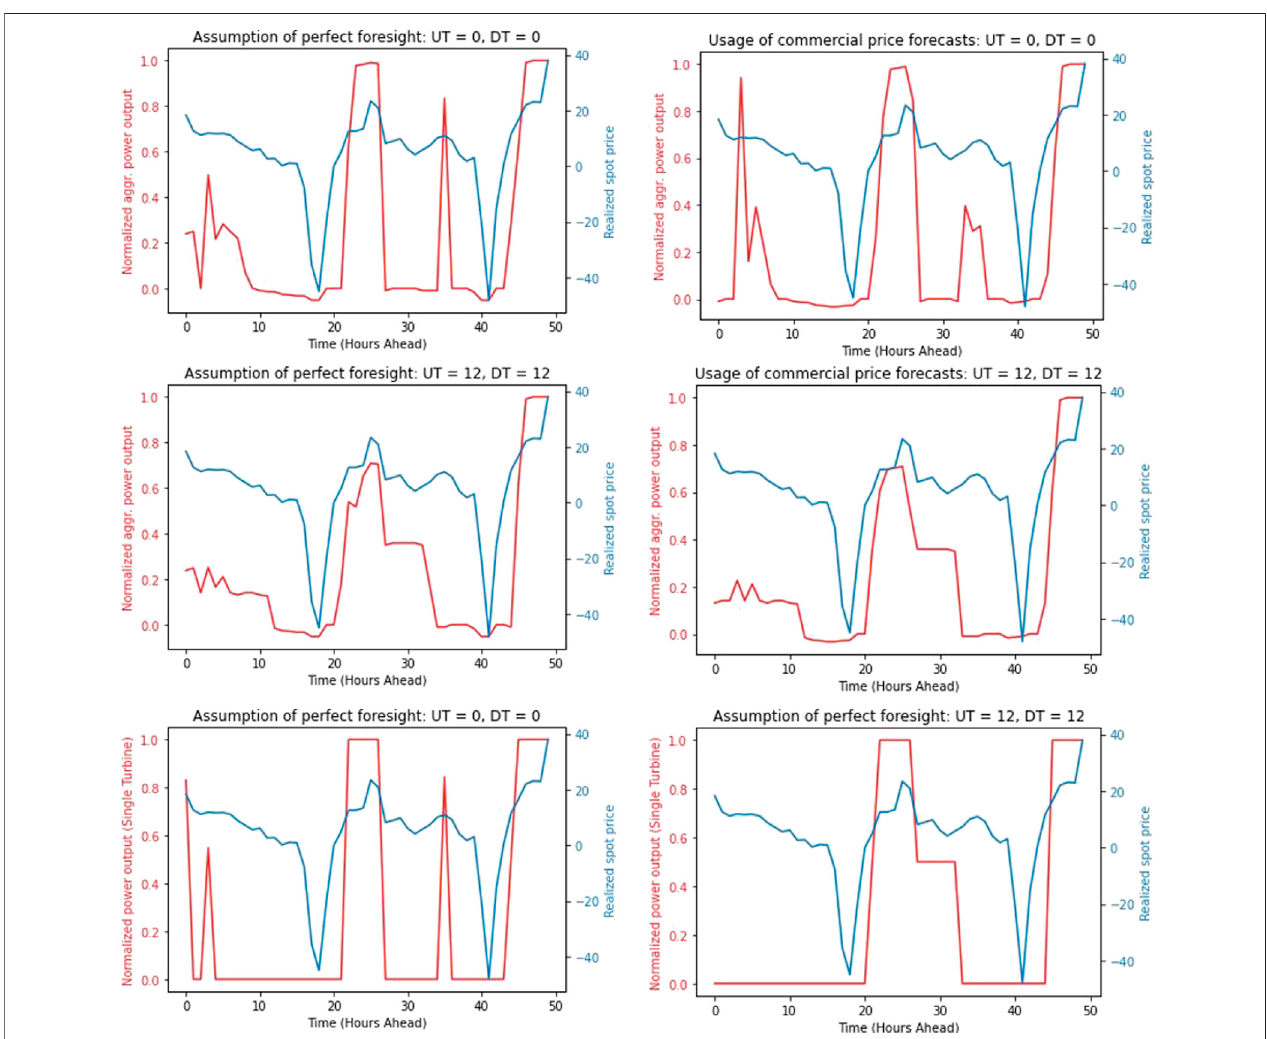
FIGURE 4 | The dependence of the revenue on the quality of the forecasts and timing constraints.